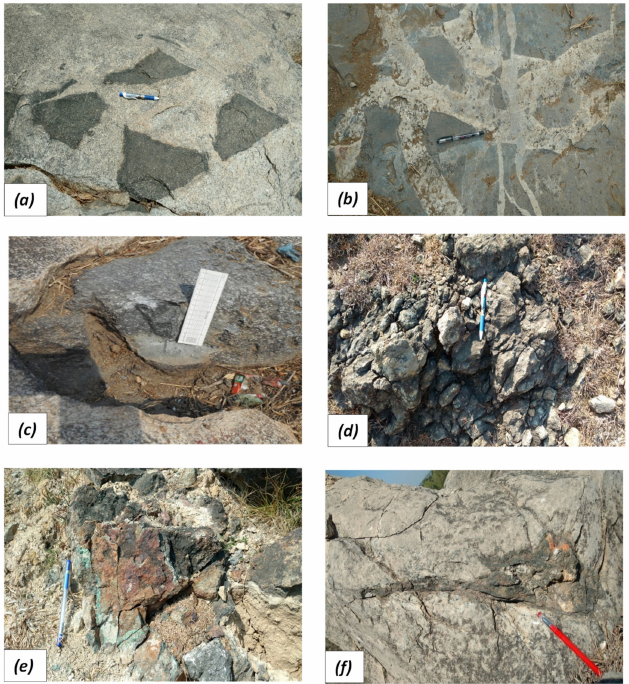
Figure 5. Field photographs showing: ( a ) xenoliths of amphibolite occurring within porphyritic biotite granite at the east of Nawagarh village; ( b ) massive amphibolite xenolith traversed by innumerable anastomosing quartzo-feldspathic pegmatite veins occurring within homophanous biotite granite at the north of Patalganga; ( c ) xenolith of migmatised amphibolite within fine-grained amphibolite rock at the north of Patal Ganga; ( d ) highly sheared, fractured, and crenulated talc tremolite actinolite schist at the east of Parvati Nagar village; ( e ) malachite staining in highly sheared talc tremolite actinolite schist at the east of Parvati Nagar village; and ( f ) xenolith of talc tremolite actinolite schist occurring within clotted anorthosite at the east of Parvati Nagar